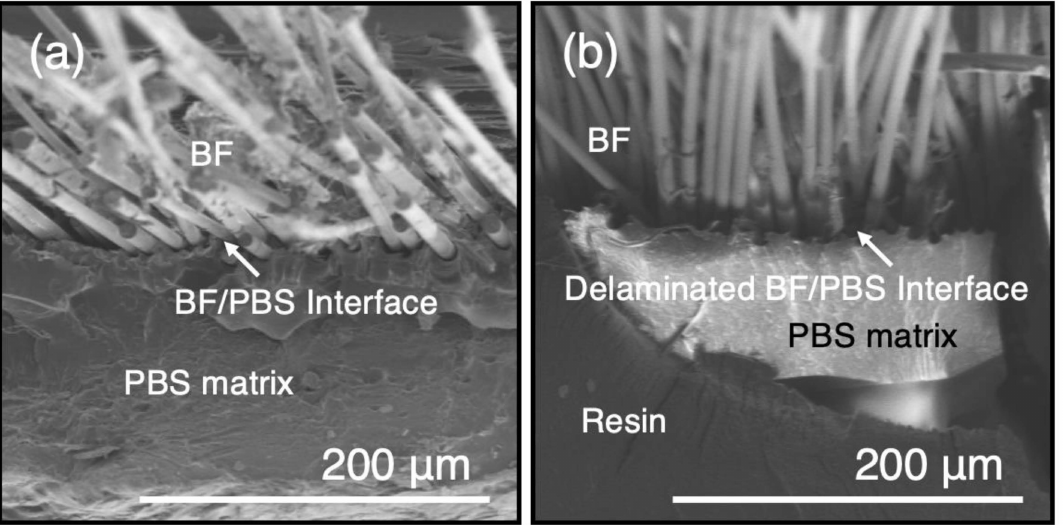
Figure 6. FE–SEM observations of the BF/PBS interface at the fracture surface of the PBS–BF composite specimens ( a ) after fabrication and ( b ) 56 days after the start of the decomposition